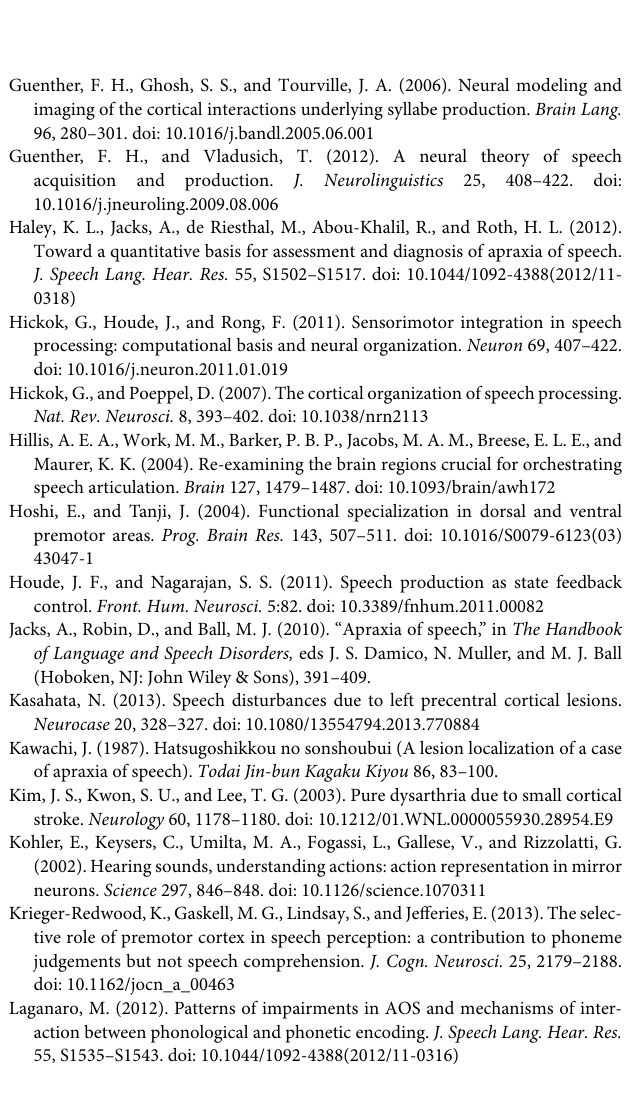
Supplementary Figure1 | Passive listening to auditorily presented nouns induced significant responses in electrodes common to the verb generation condition, that were timelocked to the auditory stimuli (Channels 29, 30, 38, 40, and